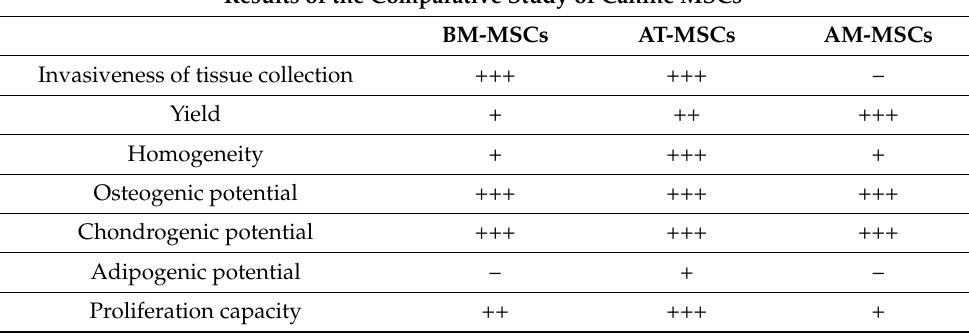
Figure 2. Morphology of canine MSCs from different sources. BM-MSCs at passage 0 (P0) day in vitro (DIV) 5 ( A1 ) and DIV15 ( A2 ); AT-MSCs at passage P0 DIV5 ( B1 ) and DIV15 ( B2 ); AM-MSCs at passage P0 DIV5 ( C1 ) and DIV15 ( C2 ). Scale bars = 50 µ m. Table 1. Comparative analysis of the common MSC properties from canine MSCs isolated from bone marrow, adipose tissue and amnion. +++, ++, + and – indicate high, moderate, low or absence of mentioned properties,